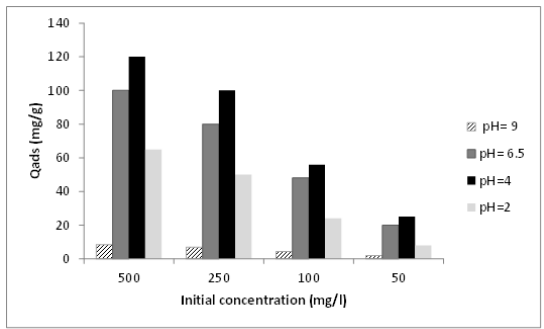
of zero charge as reported by Rheology Society. When solution pH < pHzpc, activated carbon adsorbent will re- act as positive surface and as a negative surface when solution pH > pHzpc. According to the results obtained on figure 3, the values of zeta potential of AC NaOH at different pH are the lowest, so the surface of AC NaOH was more negatively charged than those of H 2 SO 4 and